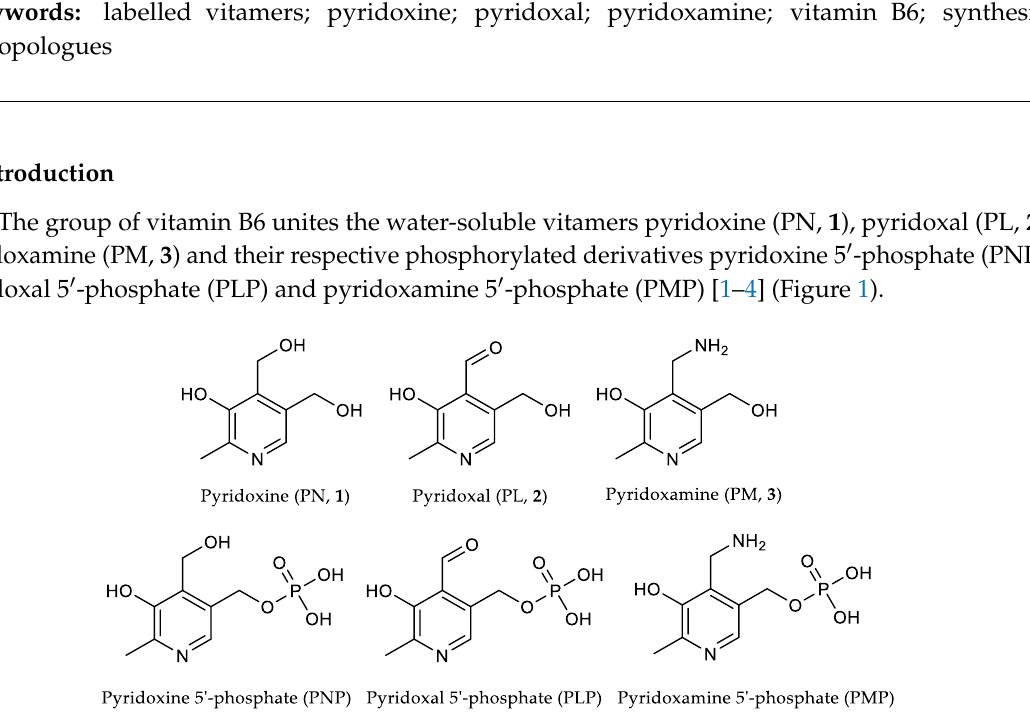
Figure 1. The term “ vitamin B6 ” refers to six substrates sharing a 2-methyl 3-hydroxypyridine structure [1 –